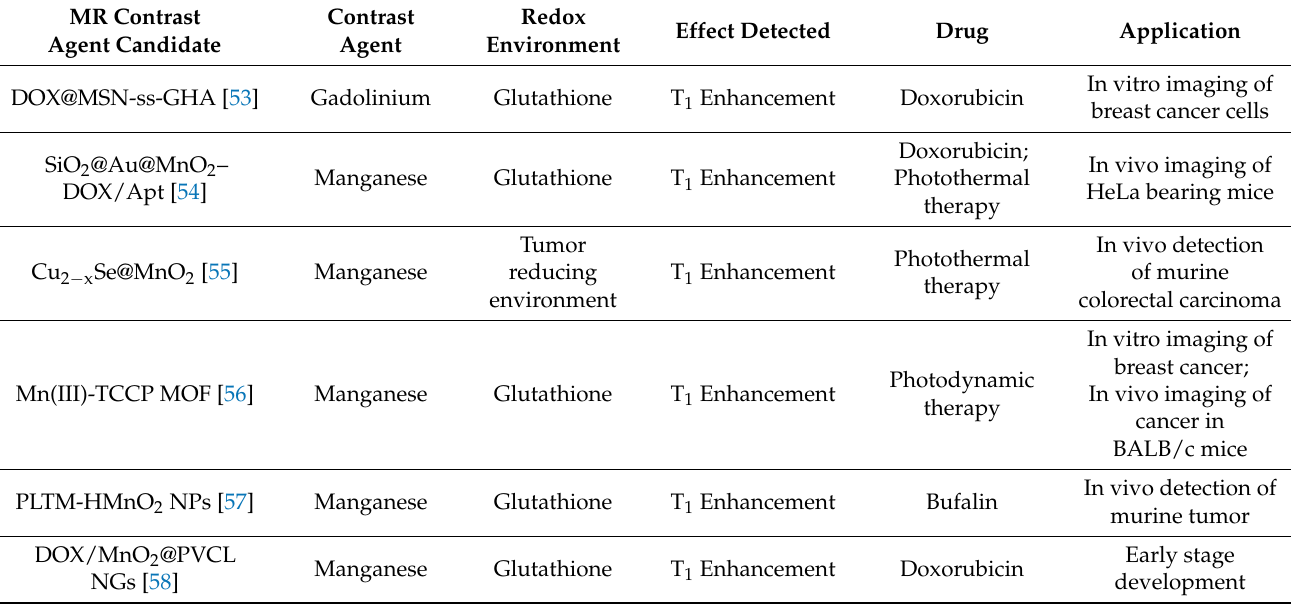
Table 3. Redox-sensitive theranostic